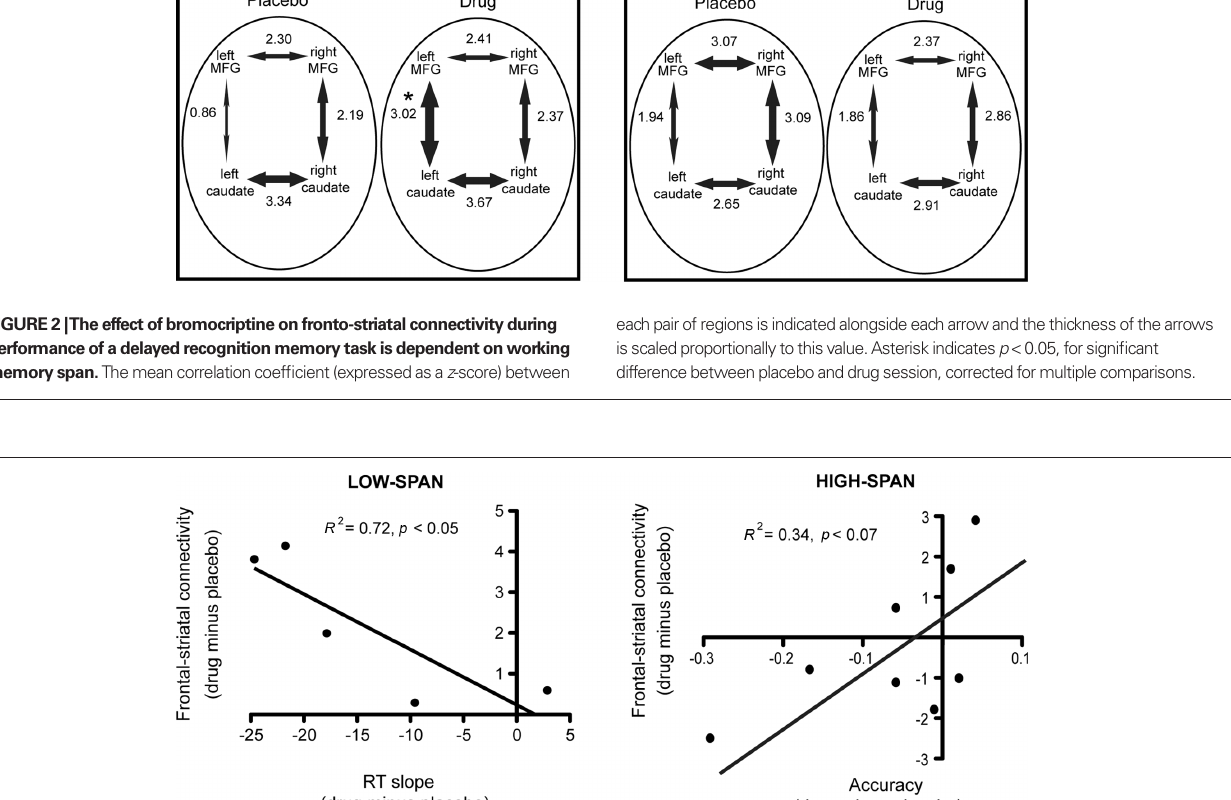
FIguRe 3 | After bromocriptine administration, changes in frontal–striatal connectivity during the probe period of the delayed recognition task correlated with changes in behavioral performance (RT slope and accuracy on high-load